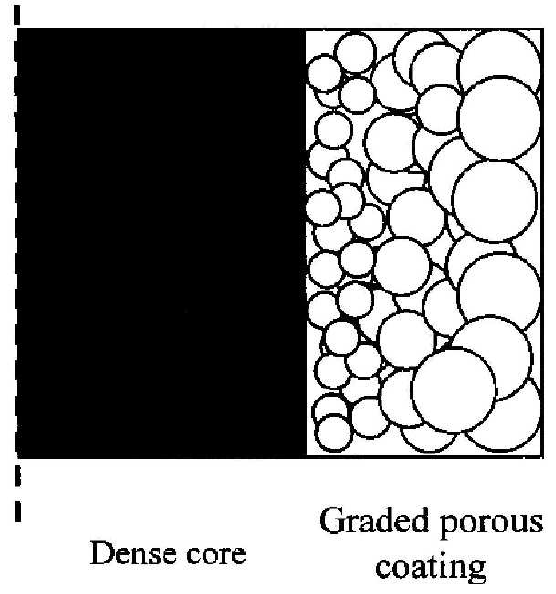
Figure 3. Schematic illustration showing the graded porous layer on the dense core.